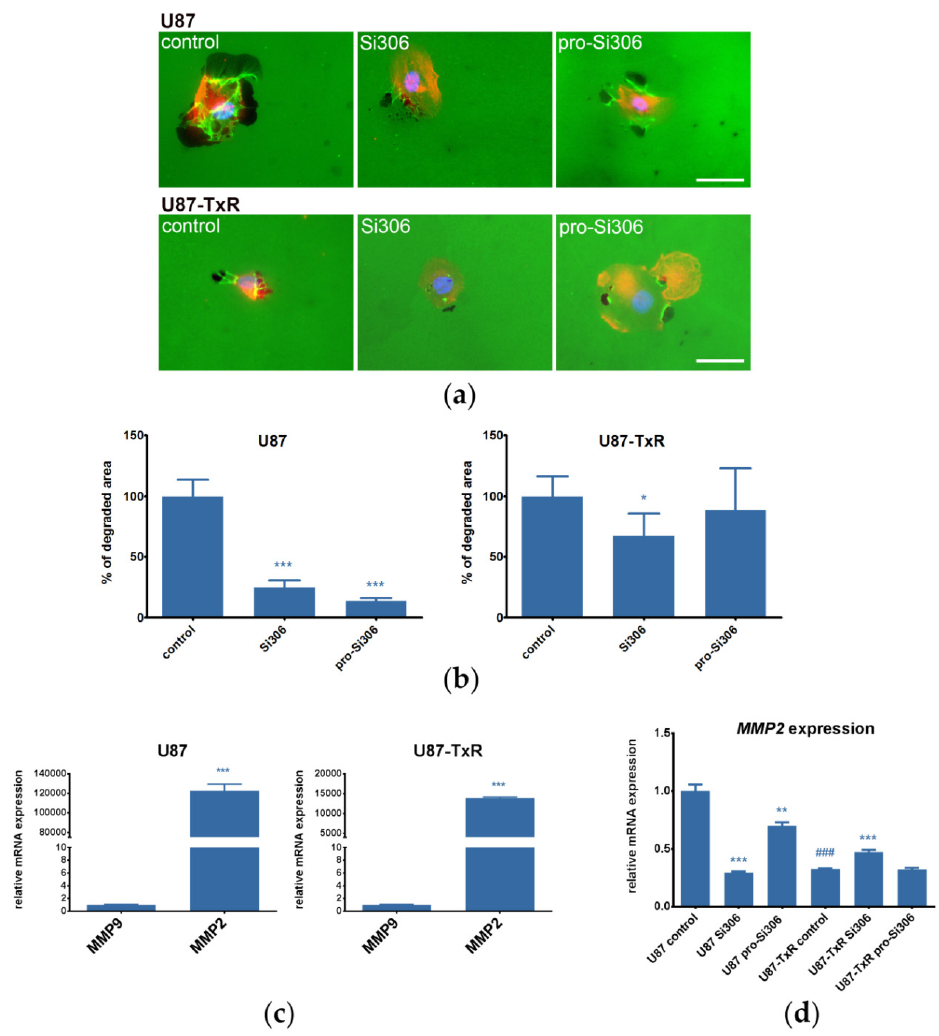
Figure 2. Si306 and pro-Si306 decrease the ability of GBM cell lines to degrade the extracellular matrix (ECM). ( a ) Representative images of gelatin degradation by U87 and U87-TxR cells treated with 5 µM Si306 and pro-Si306 for 24 h. Scale bar = 30 µm. ( b ) Percentage of area degraded by U87 and U87-TxR cells. ( c ) Relative expression of matrix metalloproteinases MMP2 and MMP9 in U87 and U87-TxR cells. ( d ) Relative expression of MMP2 in U87 and U87-TxR cells treated with 5 µM Si306 and pro-Si306 for 24 h. All values are expressed as mean ± SEM ( n = 3). Statistical significance between treated and control group is shown as * ( p < 0.05), ** ( p < 0.01), and *** ( p < 0.001). Statistical significance between untreated cell lines is shown as ### ( p < 0.001).